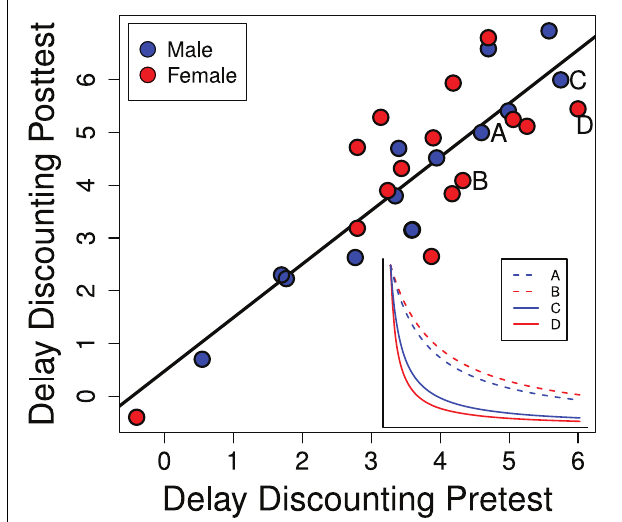
FIGURE 4 | Delay discounting scores in the pre- and post-tests (PD 28–42 and PD 58–64) are strongly correlated ( R 2 = 0 . 758; p < 0 . 0001). The inset graph shows representative delay discounting curves from two males and two females. Delay discounting scores are the degree to which the stable lever had to be reduced: higher scores indicate more rapid delay discounting which would be characteristic of a more impulsive choice.